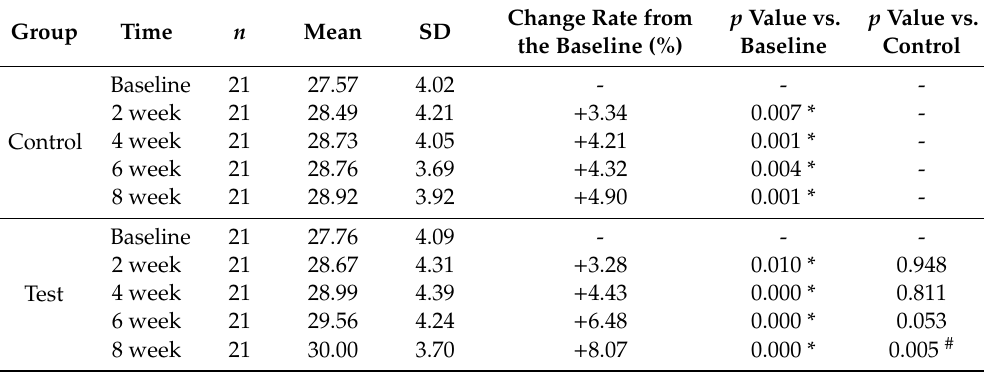
Table 9. Skin color (individual typology angle (ITA ◦ )) of the control and test groups. Group